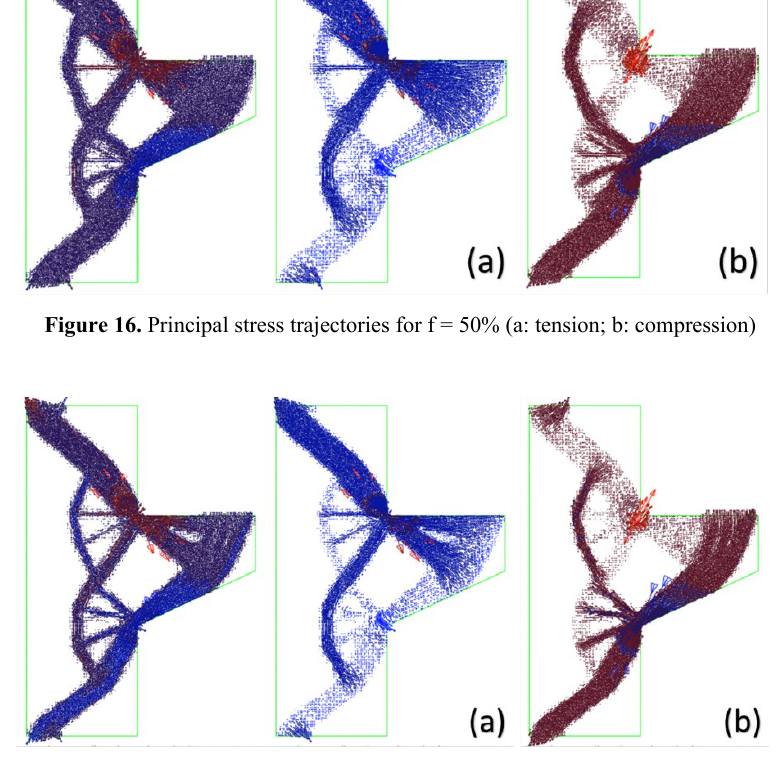
Figure 17. Principal stress trajectories for f = 40% (a: tension; b: compression)